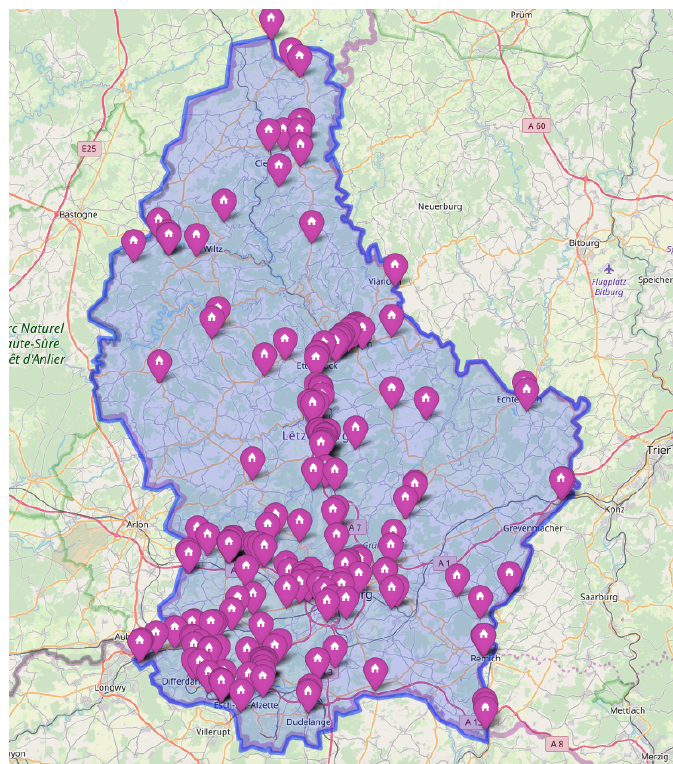
Figure 1. Clients’ spatial distribution on the complete country (Luxembourg) [7].